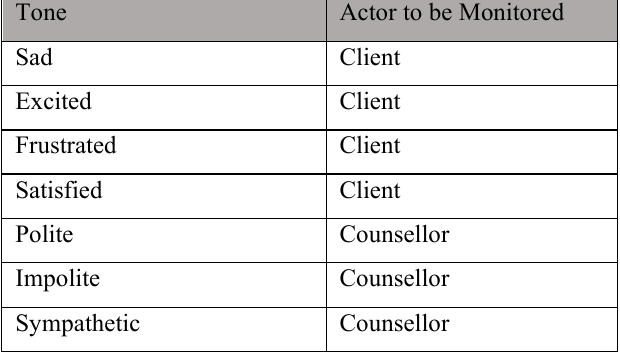
Table 2. Tones output by the IBM Watson Tone